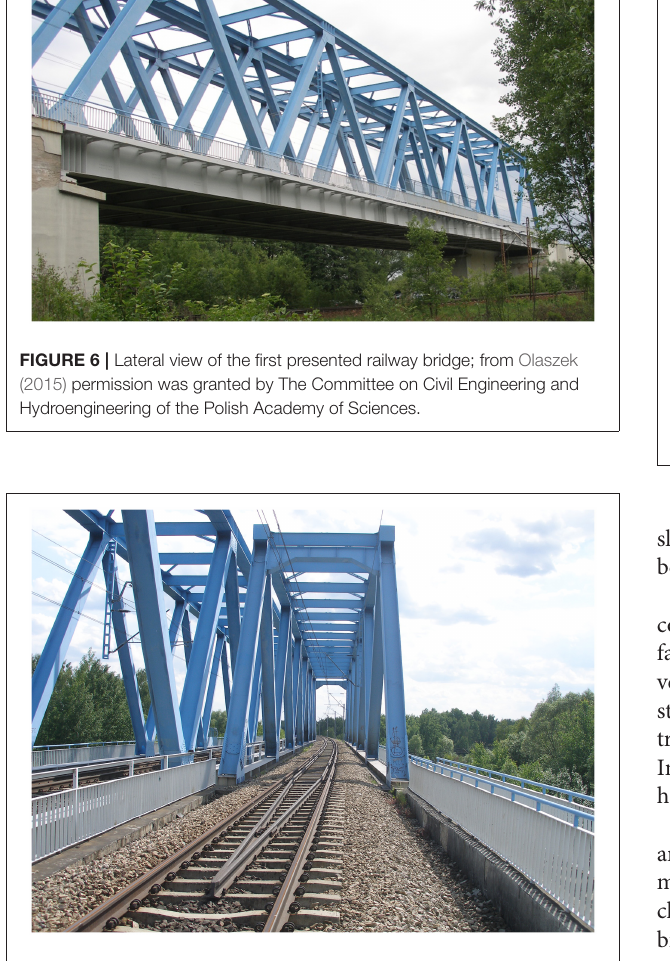
FIGURE 7 | View of the bridge from the railroad level-visible curved railway track; from Olaszek (2015) permission was granted by The Committee on Civil Engineering and Hydroengineering of the Polish Academy of Sciences.